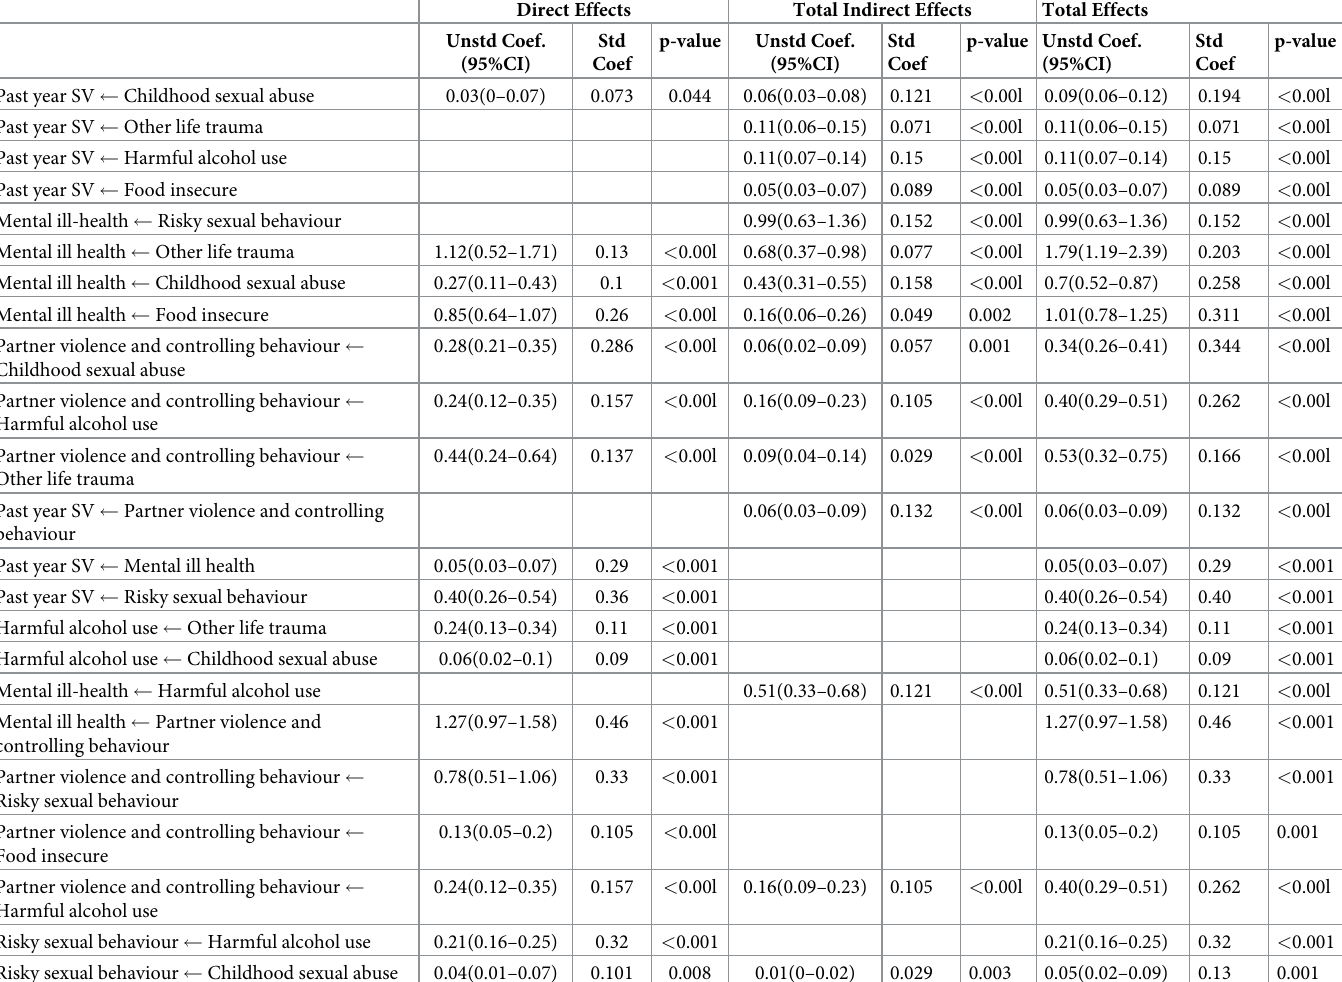
Table 4. Generalised structural model statistics. Female students survey: South African Technical Vocational Education and Training (TVET) colleges and universities